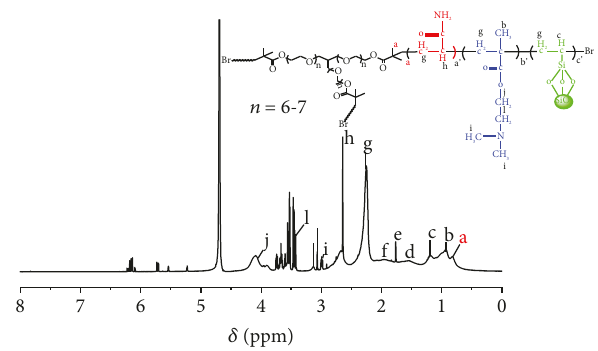
Figure 2: 1 H NMR spectrum of AM/DMAEMA/NSFM.